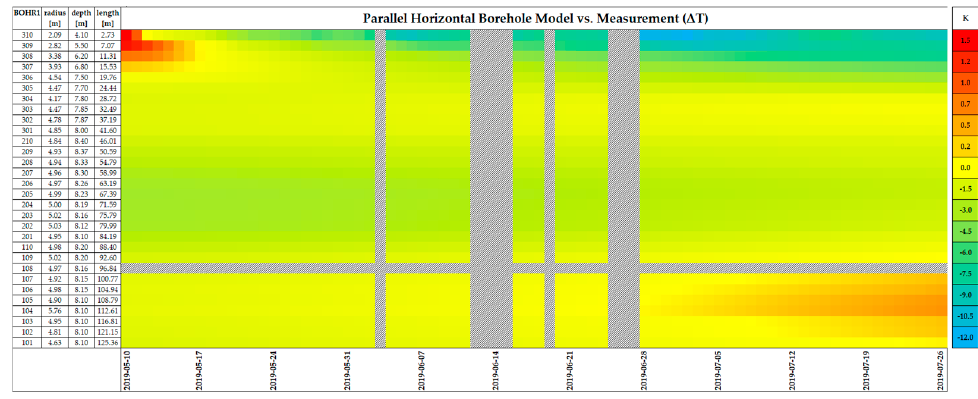
Figure 25. Model performance vs. measured values of temperature during 78–day charging period.